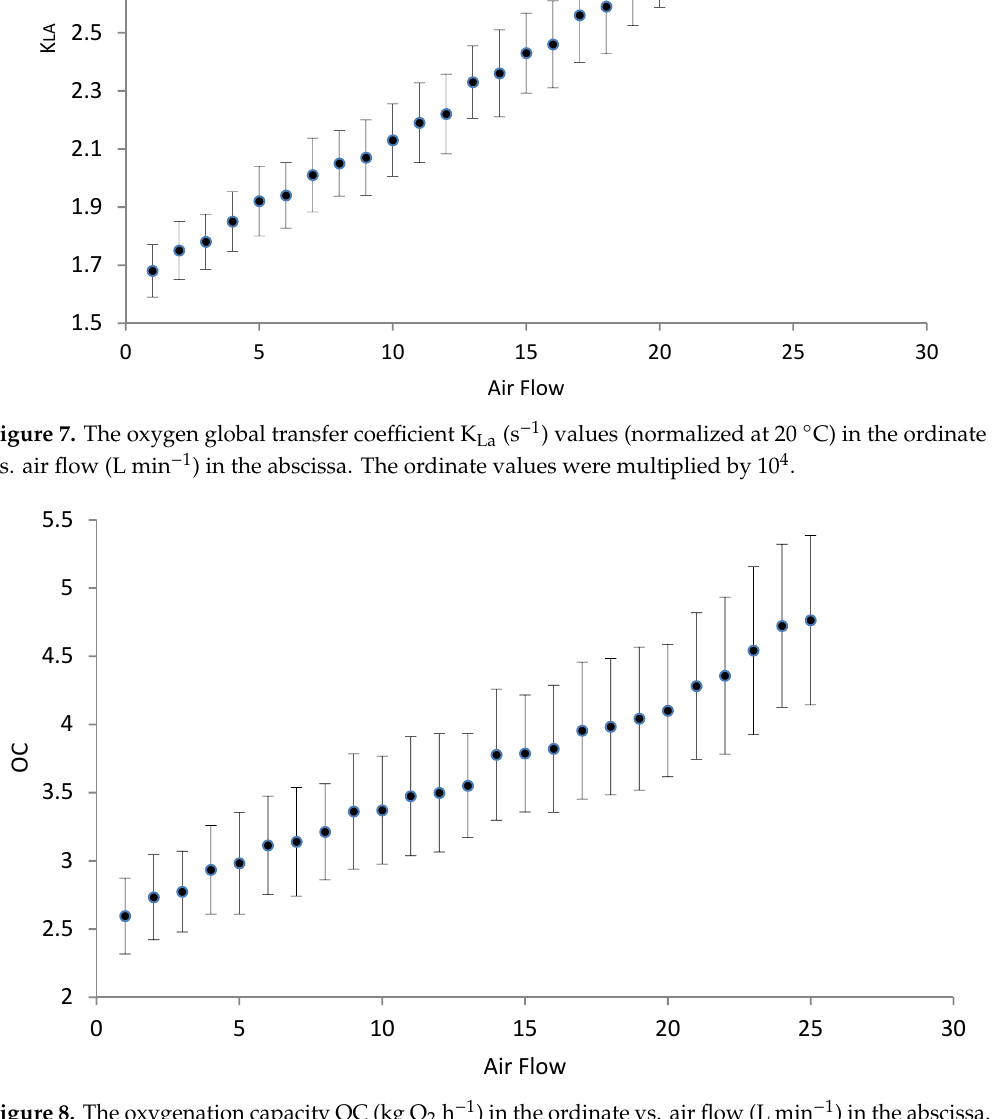
Figure 8. The oxygenation capacity OC (kg O 2 h − 1 ) in the ordinate vs. air flow (L min − 1 ) in the abscissa. The ordinate values were multiplied by 10 3 .